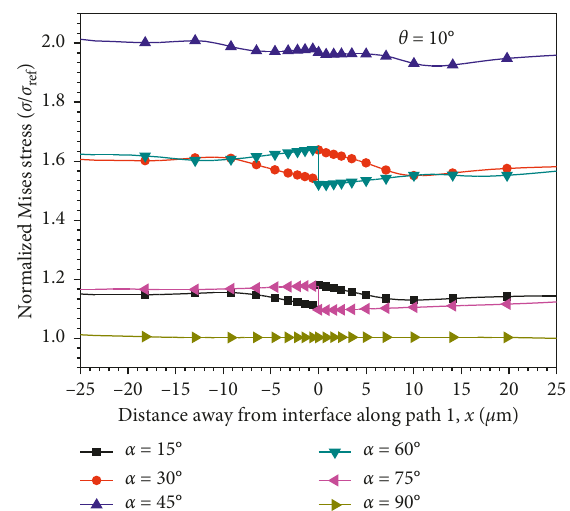
Figure 11: Mises stress scale factors along path 1 for type II